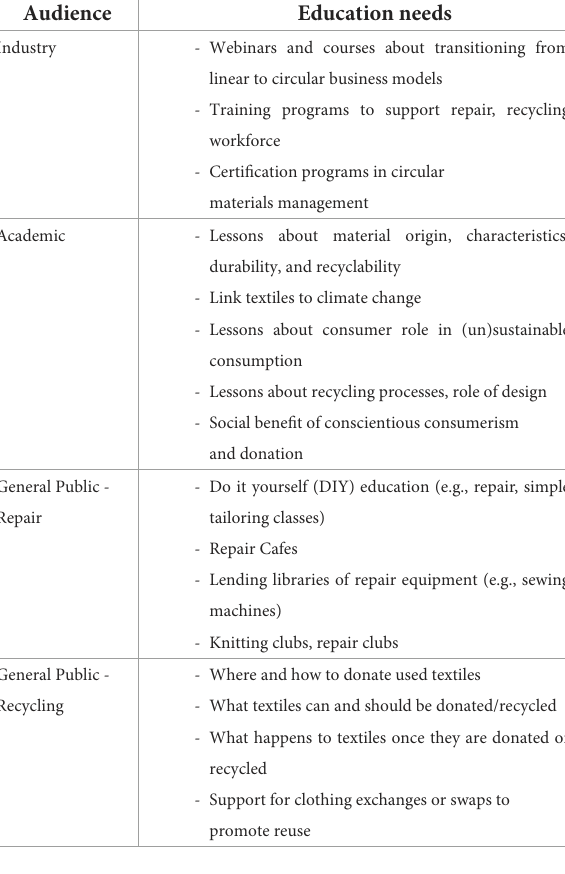
TABLE 10 Research areas and associated data/information to be